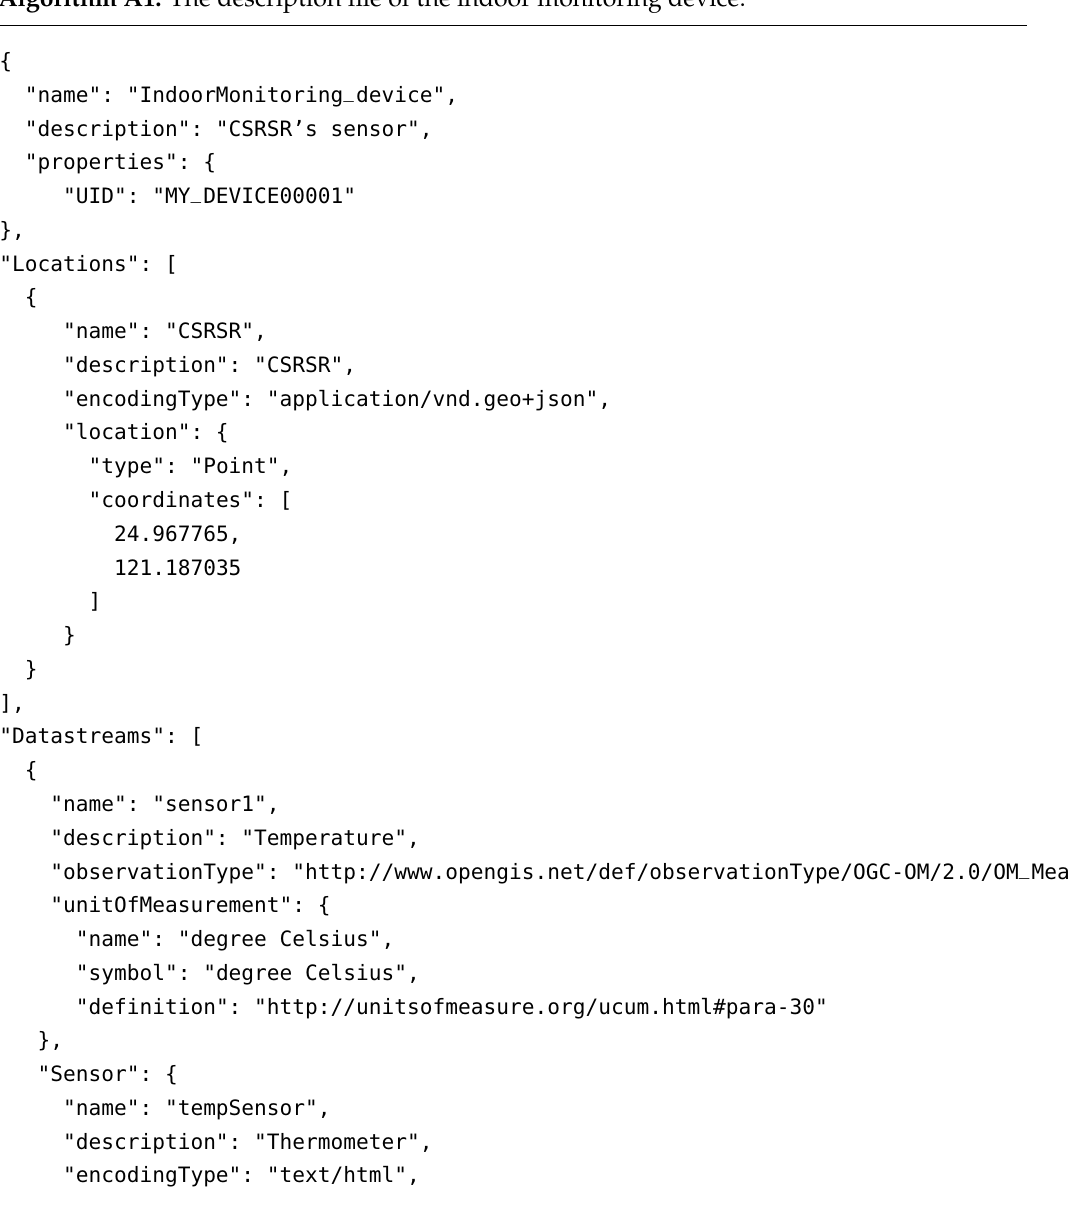
Algorithm A1. The description file of the indoor monitoring